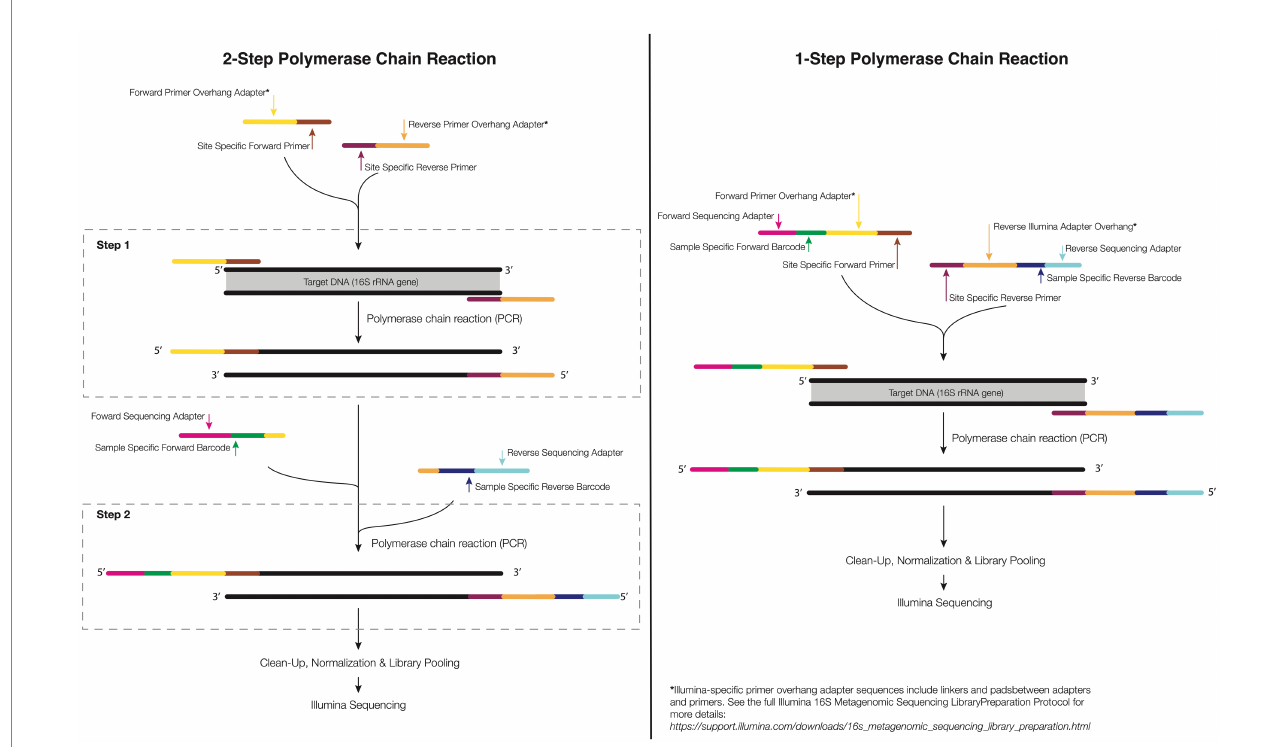
FIGURE 2 1-step and 2-step PCR amplification approach. In the 1-step PCR (right), the target gene is amplified using primers sequence composed of forward and reverse target gene primer, overhang linkers, barcodes, and Illumina adapters to bind to a flow cell in Illumina sequencing. In the 2-step PCR amplification (left), the primer of the first-step PCR contains a specific forward and reverse primer and an overhang adapter. For the second-step PCR, the primers have an overhang linker, barcodes, and the Illumina flow-cell linker